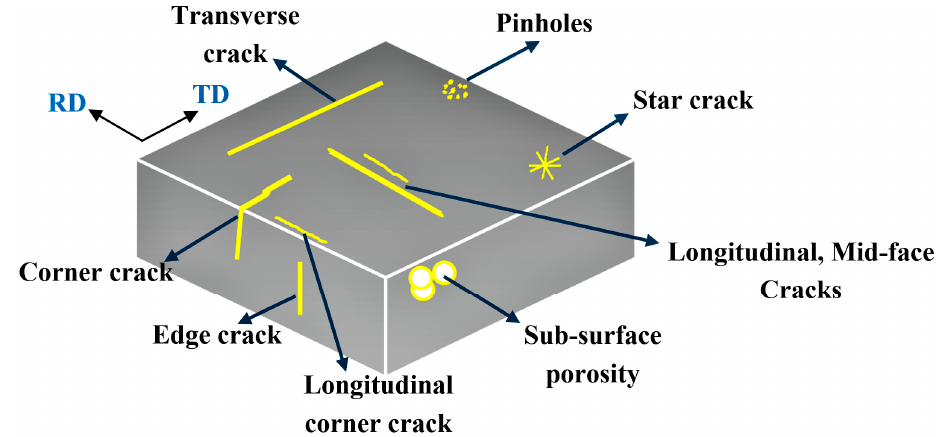
Figure 1. Schematic representation of typical surface defects in rolled products (RD: rolling direction, TD: transverse direction).